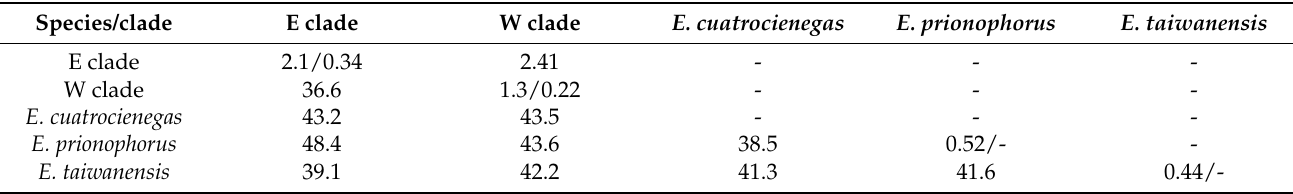
Figure 3. Maximum likelihood phylogenetic trees based on sequences of ( a ) the mitochondrial cytochrome oxidase subunit I (COI) gene and ( b ) the nuclear ITS1-5.8SrRNA-ITS2 gene region of Eucyclops serrulatus and relatives. Numbers at the nodes are bootstrap values. Outgroup sequences were obtained from GenBank, including Cyclops insignis (accession numbers KC627291-KC627294) and C. abysorum (KC627287-KC627290) for COI gene tree and Mesocyclops ogunnus (GQ848502) and M. pehqeiensis (GQ848500) for ITS gene tree. The bars between the trees indicate the “species” identified by different species delimitation methods for each gene (ABGD, GMYC, PTP) and for both genes together (STACEY). Median joining networks of ( c ) COI and ( d ) ITS haplotypes from E. serrulatus . Black dots indicate median vectors (ancestral, unsampled, or extinct haplotypes). Black hatch marks denote the number of mutational steps between haplotypes. Circles are proportional to the haplotype frequency. Table 5. Average model-corrected genetic distances (%) between two main clades (E and W) of Eucyclops serrulatus and between them and other Eucyclops species: below diagonal—COI, above diagonal—ITS, in the diagonal—values within clades